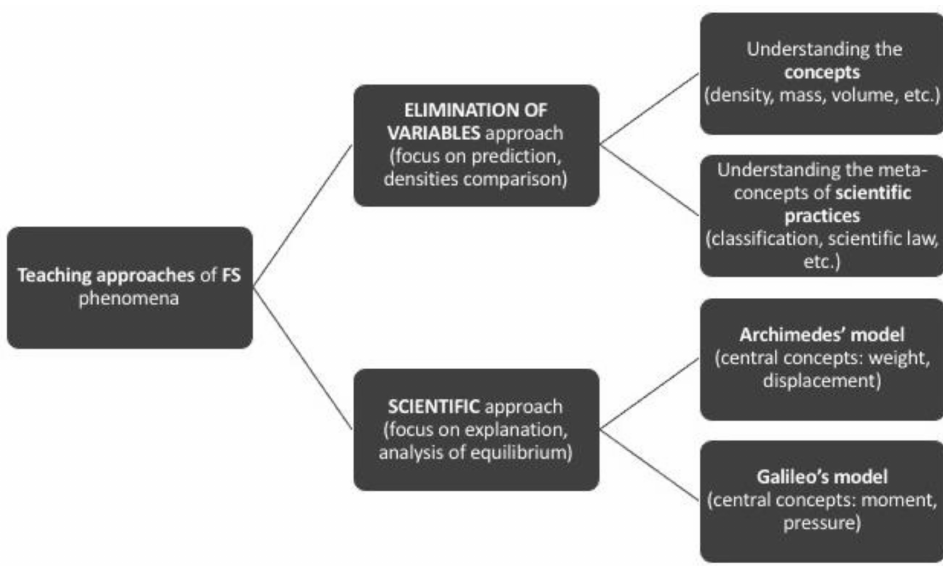
Figure 1. Categories of teaching approaches to floating and sinking phenomena; recreated by the authors according to